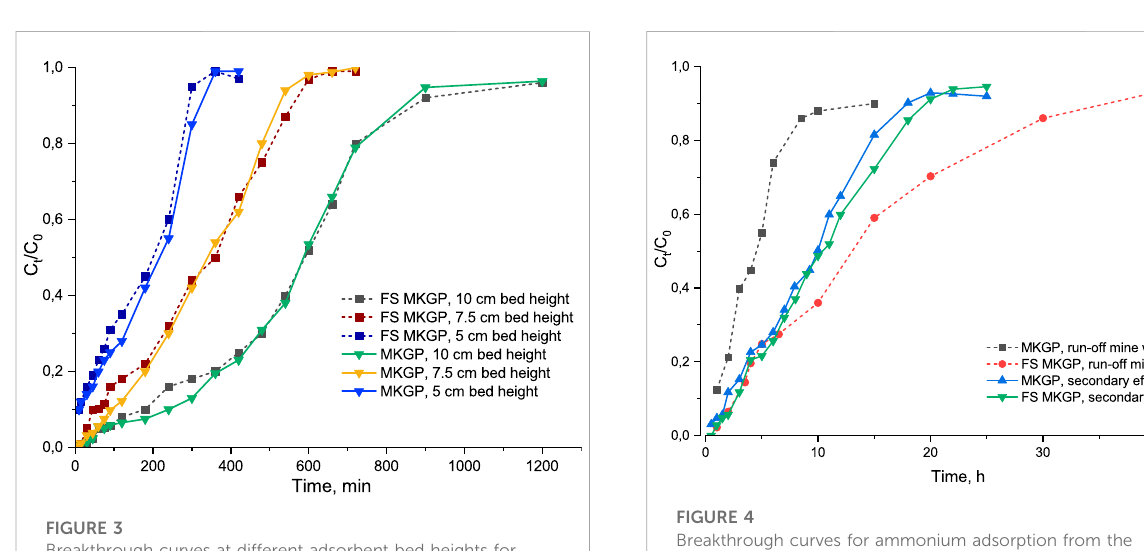
FIGURE 4 Breakthrough curves for ammonium adsorption from